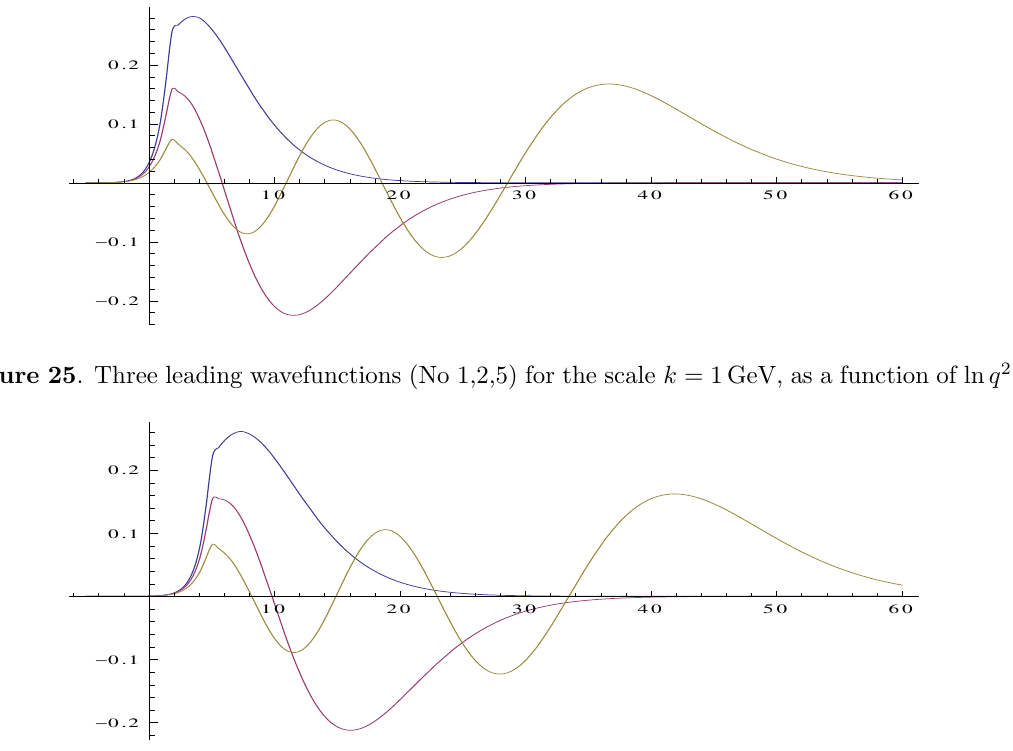
Figure 26 . Three leading wavefunctions (No 1,2,5) for the scale k = 5 GeV, as a function of ln q 2 . ‘ultraviolet’ than the leading one and should be less important in the description of the large transverse distance IR region. A similar observation was made in